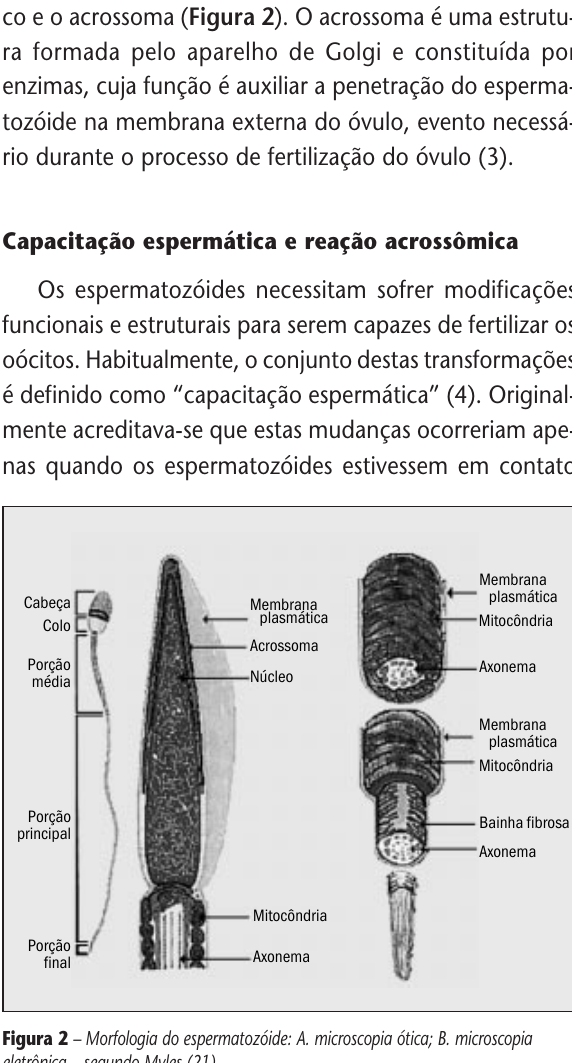
Figura 1 – Espermatogênese segundo Hermo e Clermont (11)